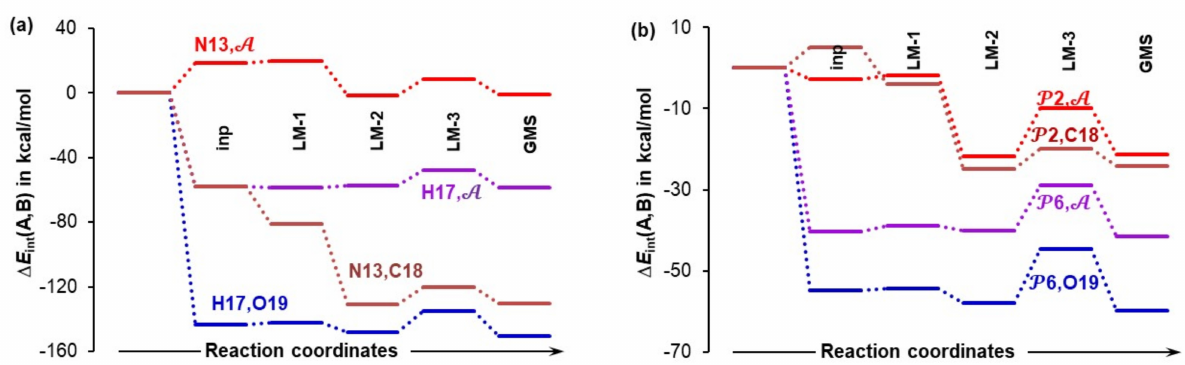
Figure 12. Trends (from an input to the global minimum structure, GMS) in the interaction energy computed for either atom-pairs or atom-molecular fragment pairs: N13, A ; H17, A ; N13,C18; H17,O19 in part ( a ) and P 2, A ; P 2,C18; P 6, A ; P 6,O19; in part ( b ). Molecular fragments P 2 = {C1,C4,H5,N13} of the HEC of proline 1b , P 6 = {C14,O15,O16,H17} of 1b , and A = {C18,O19} of acetone 2 are in 4B